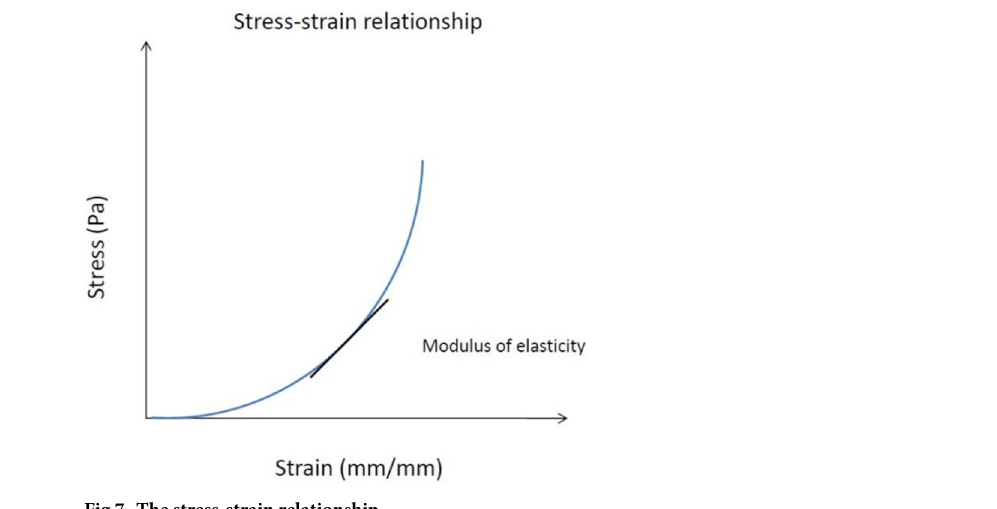
Fig 7. The stress-strain